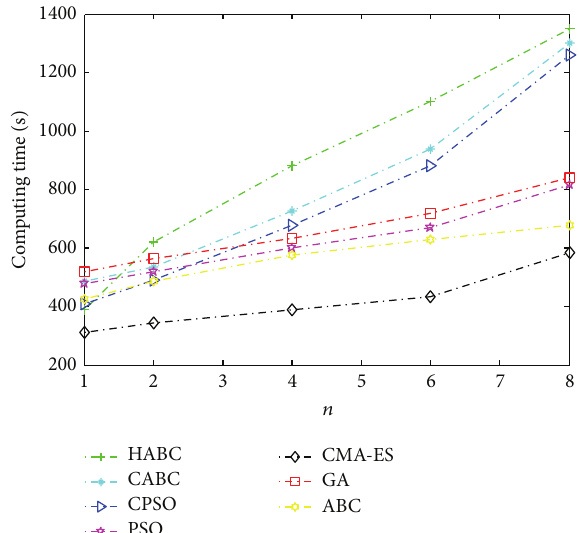
Figure 6: Computing time of all algorithms on different RNP